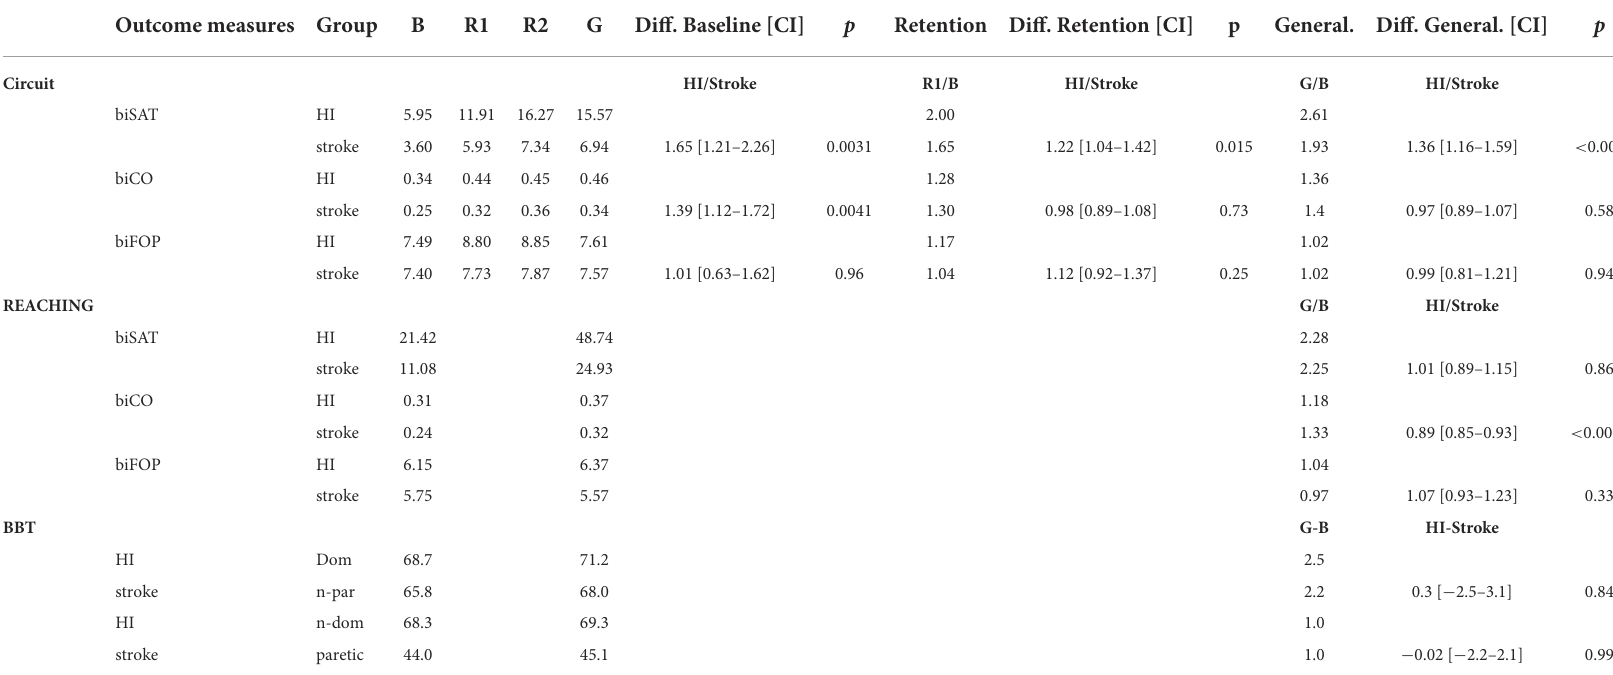
TABLE 4 Healthy individuals and patients with stroke (sham): raw data, retention, and